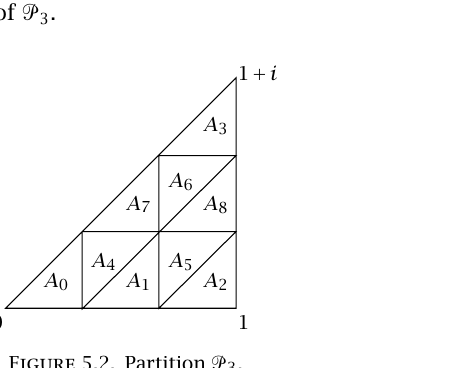
Figure 5.2 . Partition (cid:3) 3